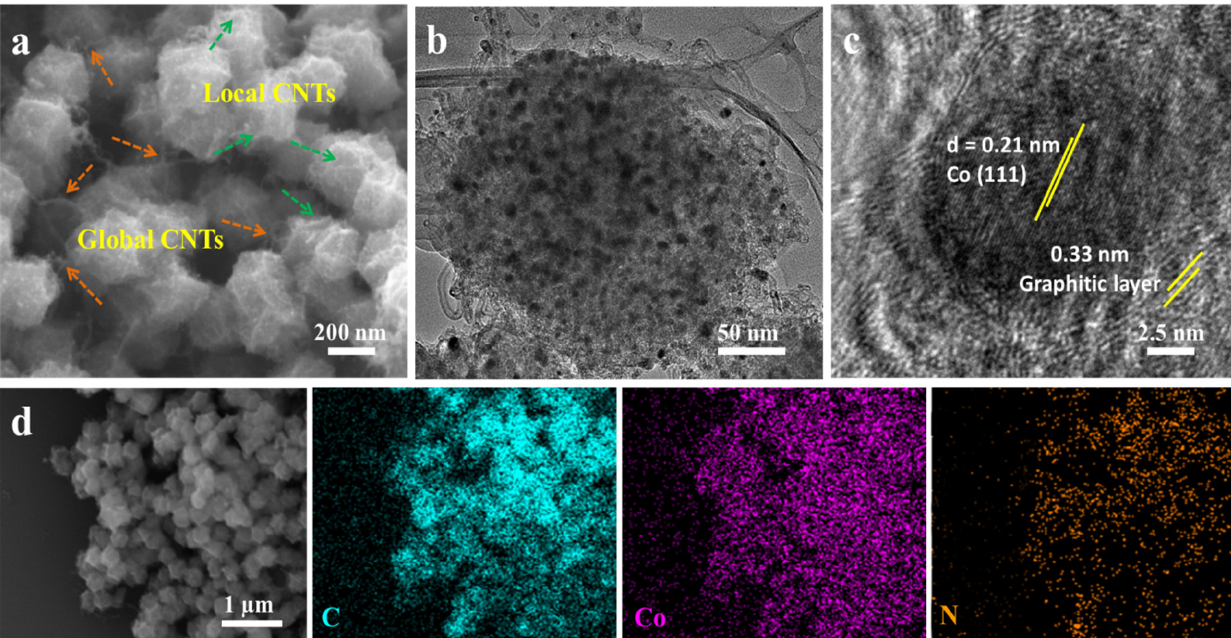
Figure 2. ( a ) SEM image (orange arrows mark global CNTs and green arrows mark local CNTs), ( b ) TEM image, ( c ) High-resolution TEM image with the index crystal plane of nanoparticles, and ( d ) Element mappings of C, Co, N elements of gl-CNTs/Co@N-C.